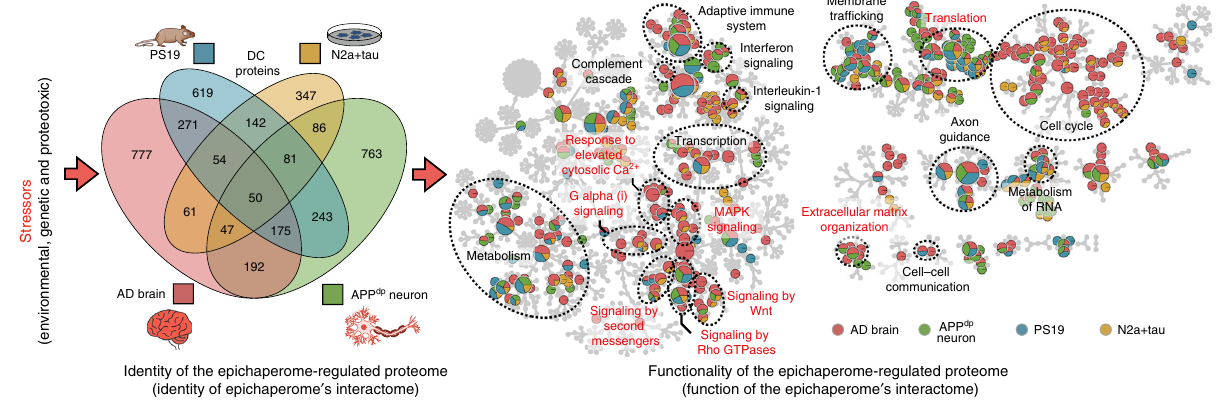
Fig. 4 Epichaperome ’ s interactome is stressor-speci fi c, yet these distinct interactomes converge functionally on synaptic protein pathways. The identity and function of the epichaperome and its interactome following the indicated neuronal stresses are shown in Venn diagram and pathway enrichment analysis representation, respectively. In the Venn diagram, each circle represents the number of proteins affected by the switch of the chaperome into epichaperome by a speci fi c stressor condition. In the Reactome map, each pie (circle) represents a function (i.e., a protein pathway). If the circle is blue, yellow, red and green, all four stressors (or the stressors characteristic of each four conditions) induce imbalances in that speci fi c protein pathway. If a circle is exclusively red, the pathway alteration is AD speci fi c. The location of protein pathways with major roles in synaptic plasticity is denoted in red lettering. Other highly represented functional clusters are presented in black lettering. The interactive Cytoscape fi le associated with this fi gure provides the identity of each protein pathway and of proteins identi fi ed in each pathway. See also Fig.